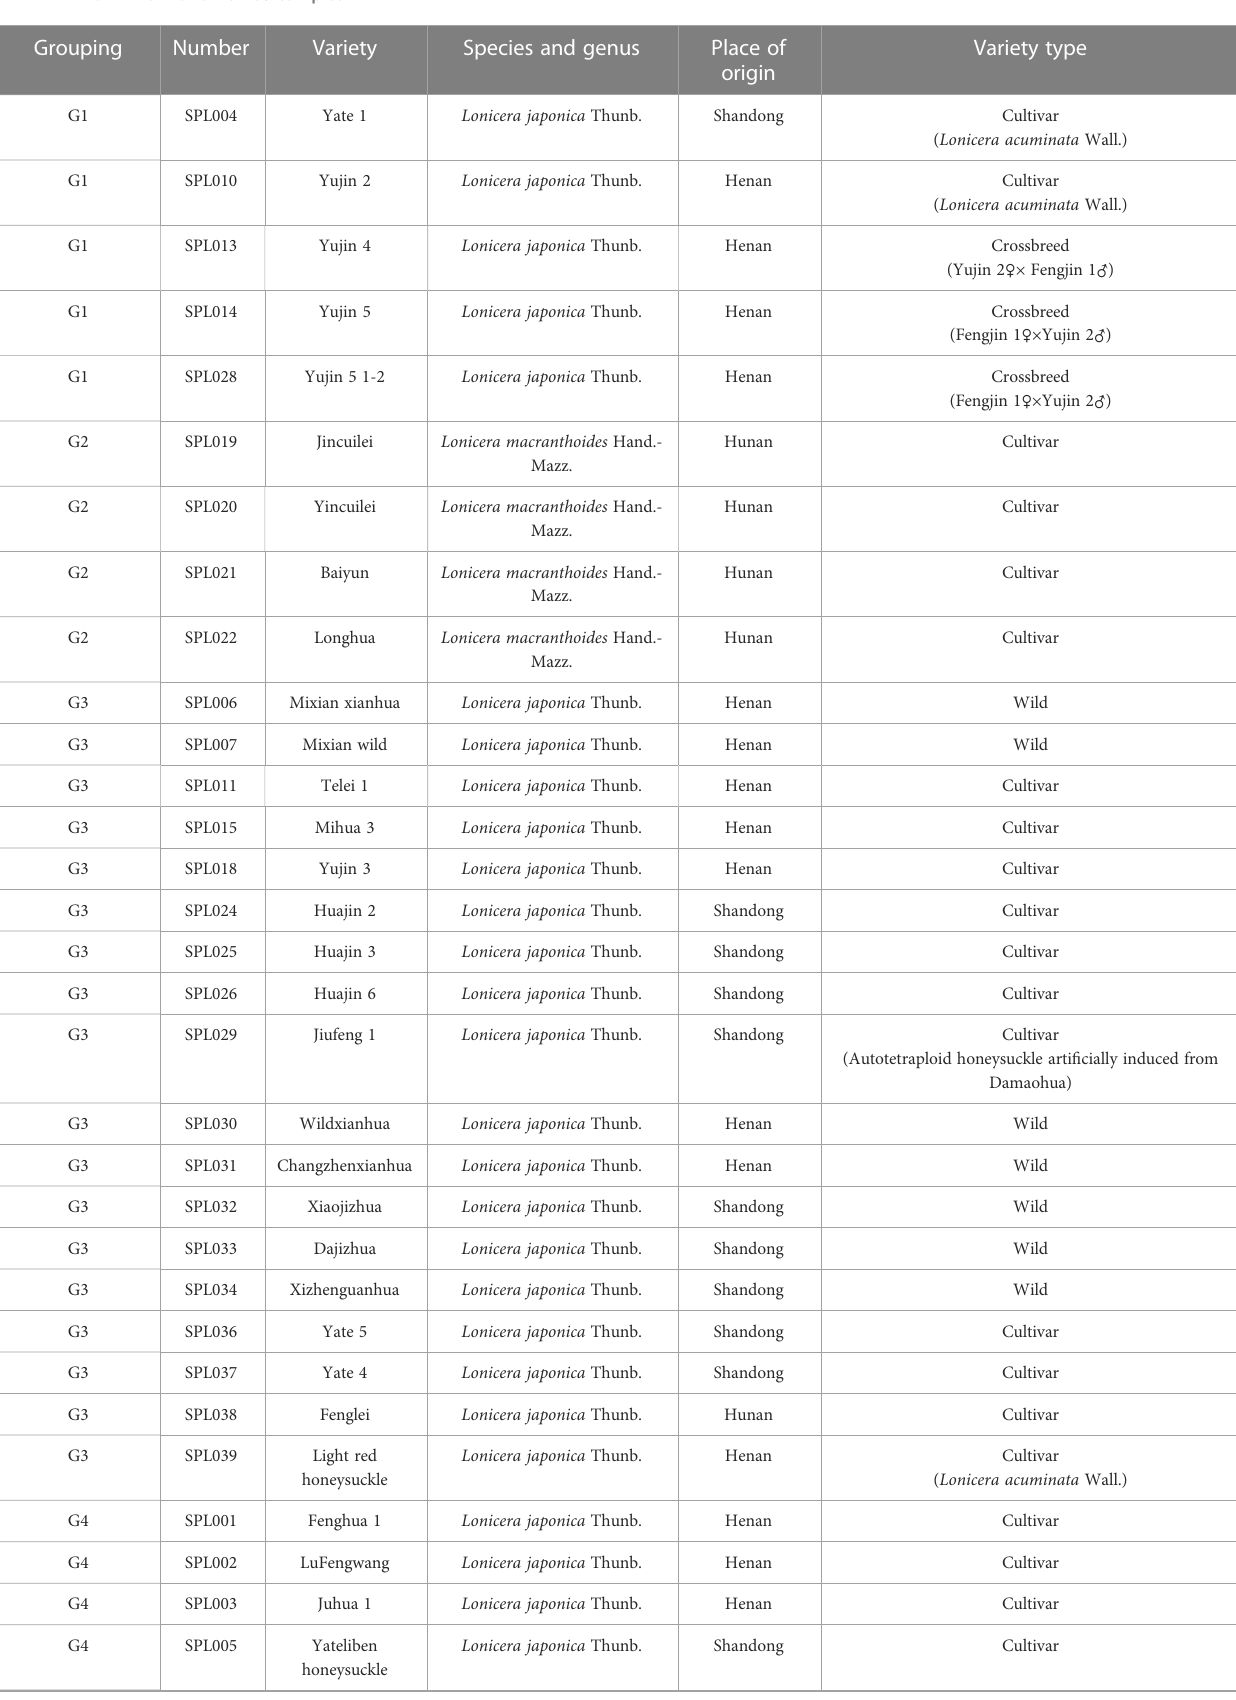
TABLE 1 Main information on 39 samples.